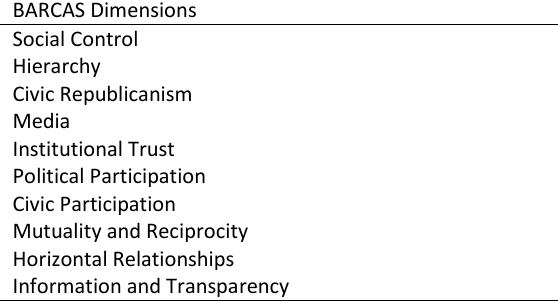
Table 5. BARCAS dimensions to calculate social